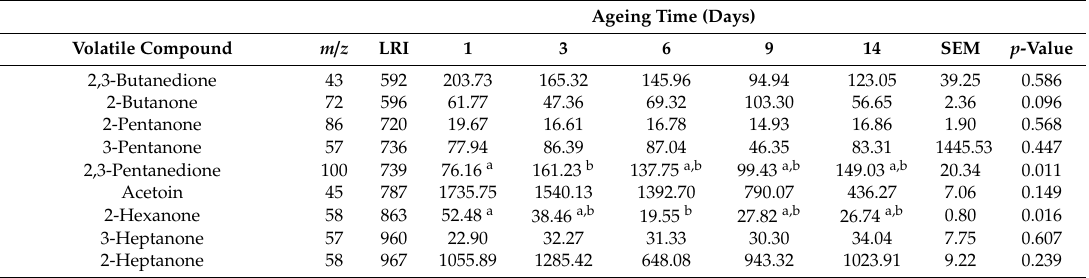
Table 3. E ff ect of aging time in the ketones content, expressed as quantifier area units (AU × 10 3 / g), of donkey meat steaks aged for 14 days under vacuum conditions ( n = 10 samples for each aging time). Ageing Time (Days) Volatile Compound m / z